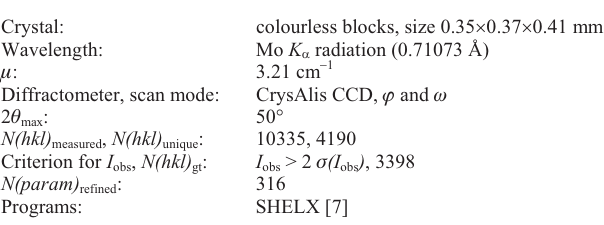
Table 1. Data collection and handling.